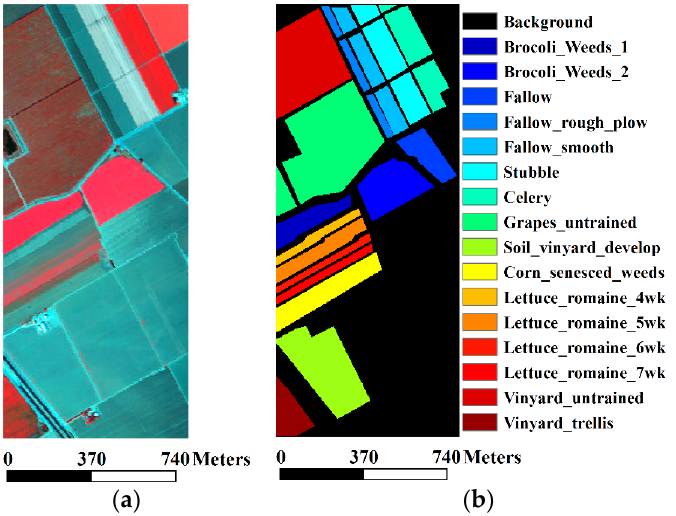
Figure 6. AVIRIS Salinas data set and the corresponding ground truth data: ( a ) three-band color composite image (bands 47, 27 and 13); and ( b ) ground truth data.